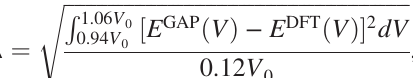
¼ 2 . 75 Å, in (fraction of atoms with number of neighbors i within r i c , in eV) for amorphous structures resulting from ac , the energy difference ac , and the DFT- ac . ac